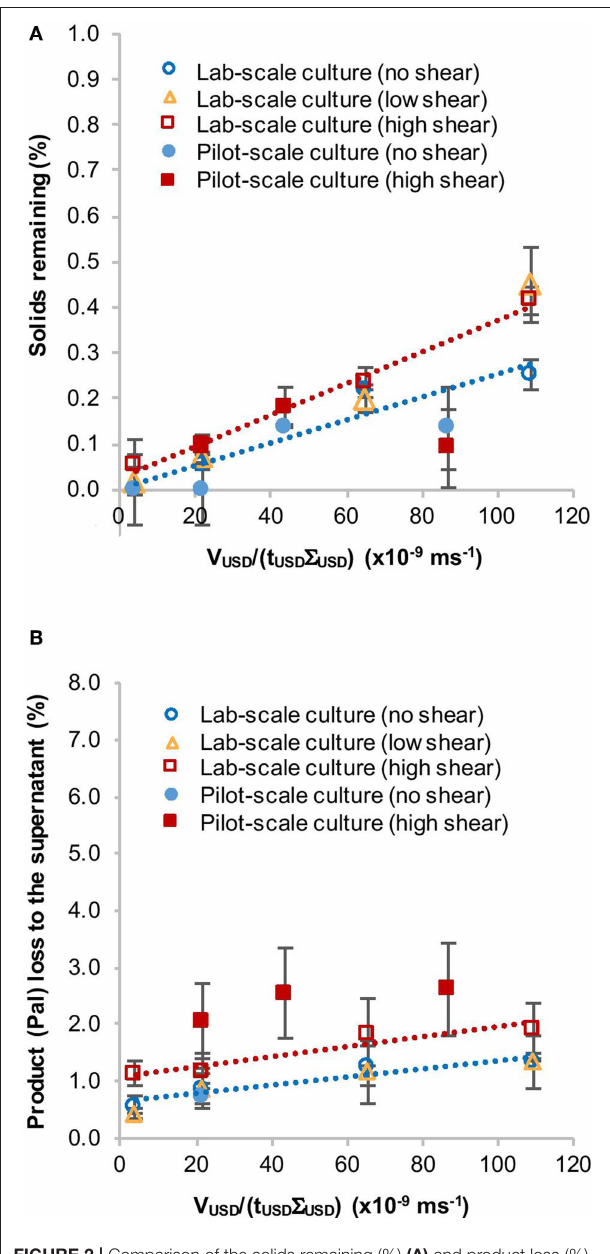
FIGURE 2 | Comparison of the solids remaining (%) (A) and product loss (%) to the supernatant (B) after ultra scale-down (USD) centrifugation of a lab-scale and a pilot-scale Chlamydomonas reinhardtii TN72_pal culture. Both types of culture were exposed to two levels of shear in the rotating shear device followed by bench-scale centrifugation at equivalent settling area. Solids remaining (%) were determined by optical density measurements and the loss of the product Pal (%) to the supernatant by quantitative western blot analysis. The same pilot-scale culture was used for the 200L.h − 1 GEA Westfalia CSA-1 run (see Figure 3 and Table 1 ). The linear regression lines correspond to the lab-scale culture data for high shear (red) and no shear (blue). Error bars represent ± 1 SD ( n ≥